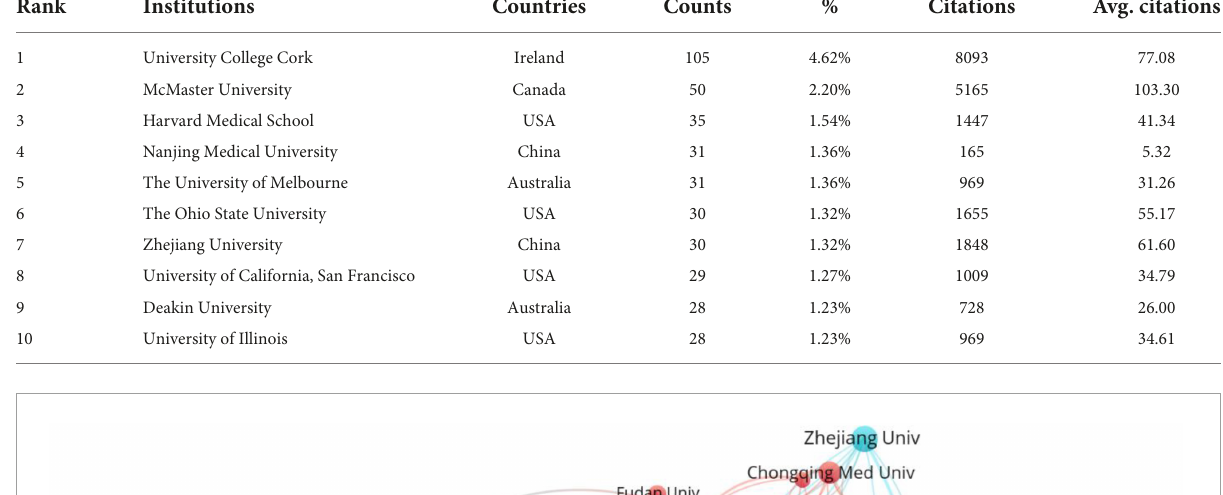
TABLE 2 The top 10 institutions research the gastrointestinal microbiome and neuroscience.